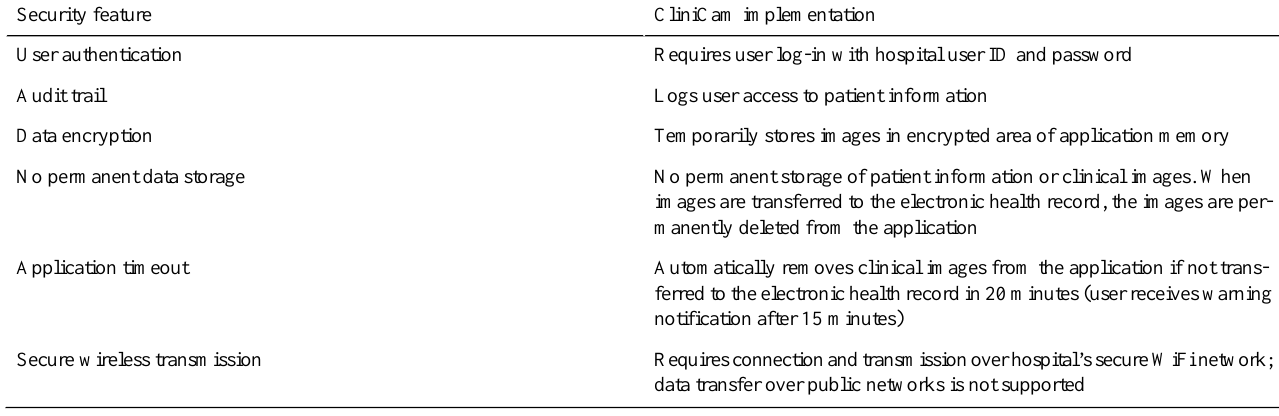
Table 1. Security features implemented to make CliniCam secure and Health Insurance Portability and Accountability Act (HIPAA) compliant.